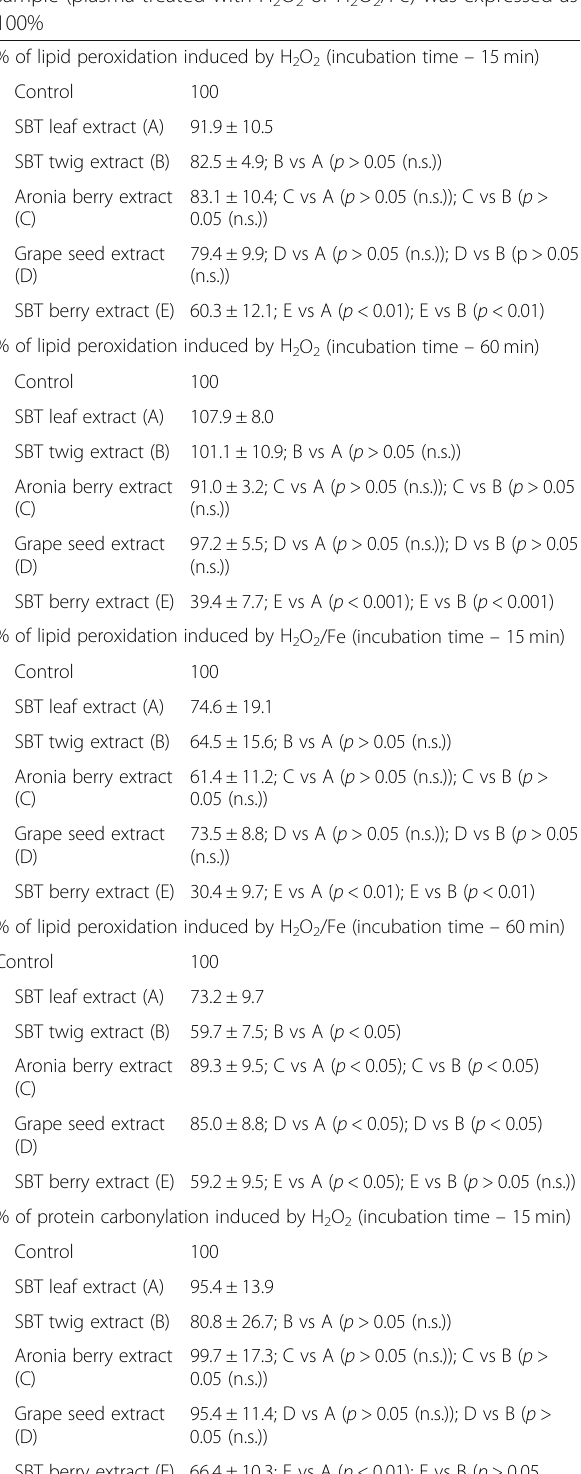
Table 2 Comparison of antioxidant properties of SBT twig and leaf extracts with properties of selected berry extracts (50 μ g/ mL; 15 and 60 min) in human plasma. Data represent means ± SD of 5 – 12. The level of marker of oxidative stress in control sample (plasma treated with H 2 O 2 or H 2 O 2 /Fe) was expressed as